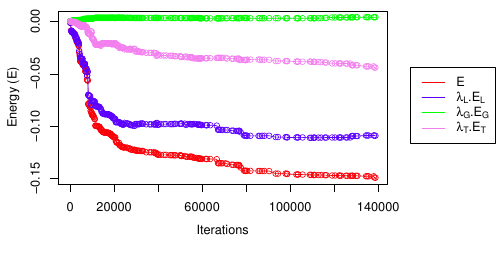
Figure 2: Evolution of the energies during the reconstruction process, for the dataset presented in Figure 1. Here, we use the weighting coefficients λ D = 0 . 1 , λ T = 0 . 7 and λ G = 0 . 2